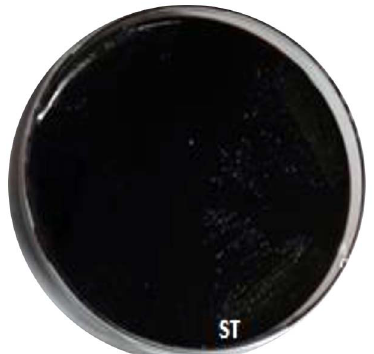
Fig. 1. Black color showing positive biofilm formation of ST isolate using CRA.